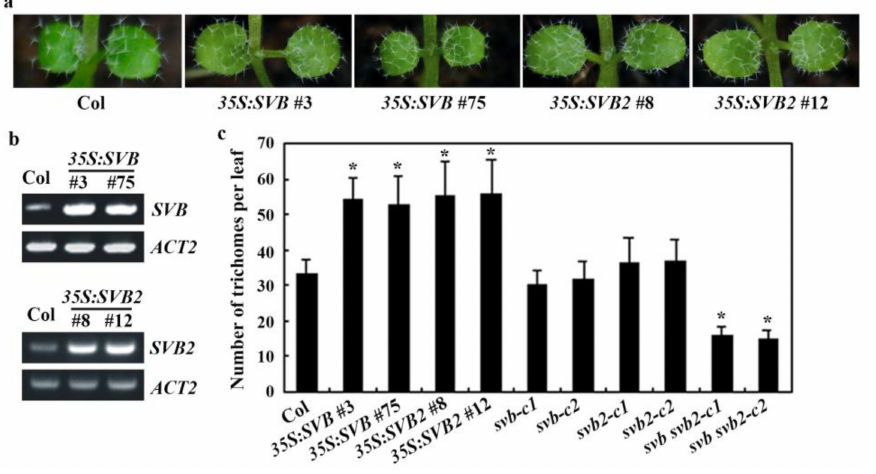
Figure 9. Overexpression of SVB and SVB2 promote trichome formation. ( a ) Trichome formation in the Col wild type, the 35S:SVB and 35S:SVB2 transgenic plants. Seeds of the Col wild type, the 35S:SVB #3, 35S:SVB #75, 35S:SVB2 #8 and 35S:SVB2 #12 transgenic plants were sown directly into soil pots and grown in a growth room. Trichome formation on the first two rosette leaves of 10-day-old seedlings were examined under a Motic K microscope and pictures were taken by using an EOS 1100D digital camera connected to the microscope. ( b ) Expression of SVB and SVB2 in the